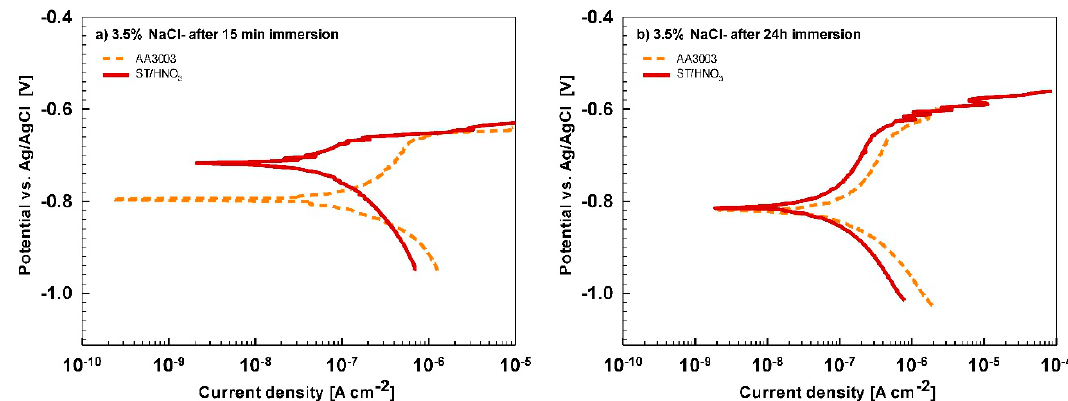
Figure 1. Potentiodynamic polarization curves recorded for the as-received AA3003 and the chemically pre-treated AA3003 (ST/HNO 3 ) in 3.5% NaCl after immersion times of ( a ) 15 min, ( b ) 24 h. The scan rate was 1 mV/s.